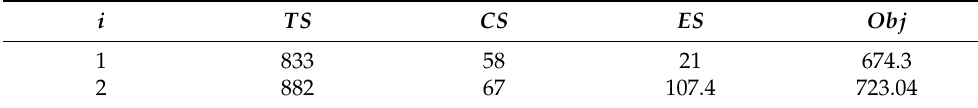
Table 5. DSS results.